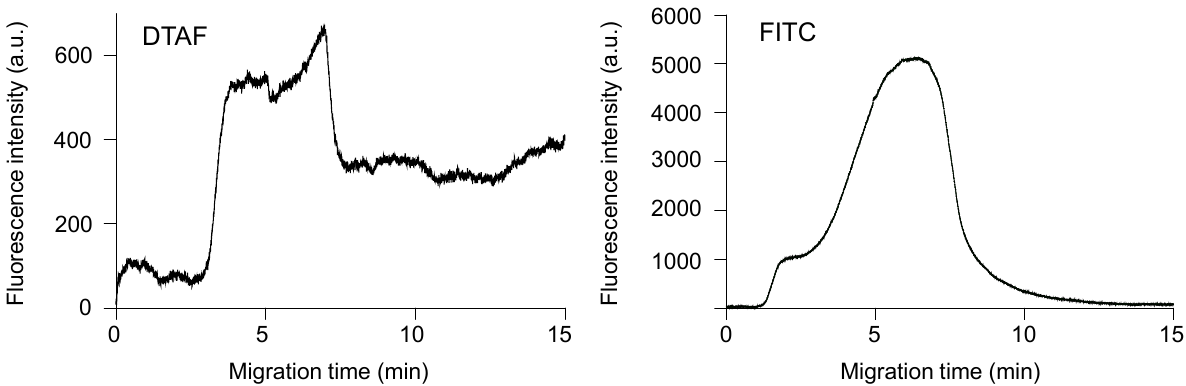
Figure 3. Time-course of fluorescence intensity changes of monophosphorylated β -casein concentrated in Phos-tag acrylamide gel upon introducing 5-(4,6-dichlorotriazinyl)aminofluorescein (DTAF) or fluorescein isothiocyanate (FITC).